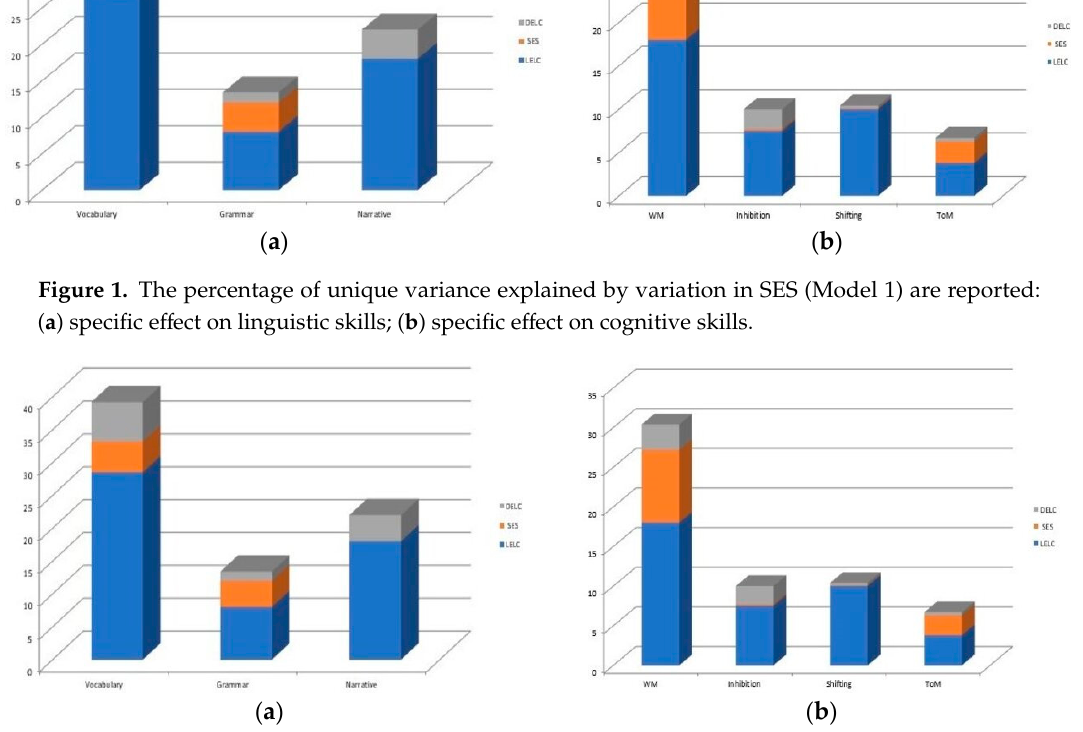
Figure 2. The percentage of unique variance explained by variation in BE (Model 2) are reported: ( a ) specific effect on linguistic skills; ( b ) specific effect on cognitive skills.